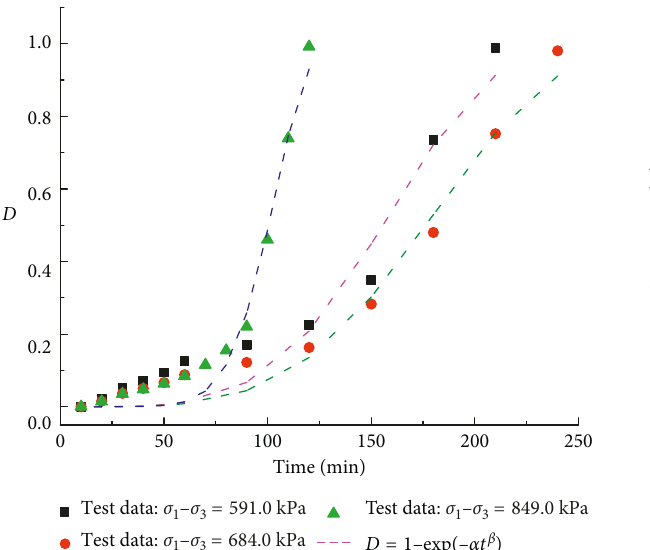
Figure 11: Comparison between the improved Burgers creep damage model curve with the test result from Li et al.